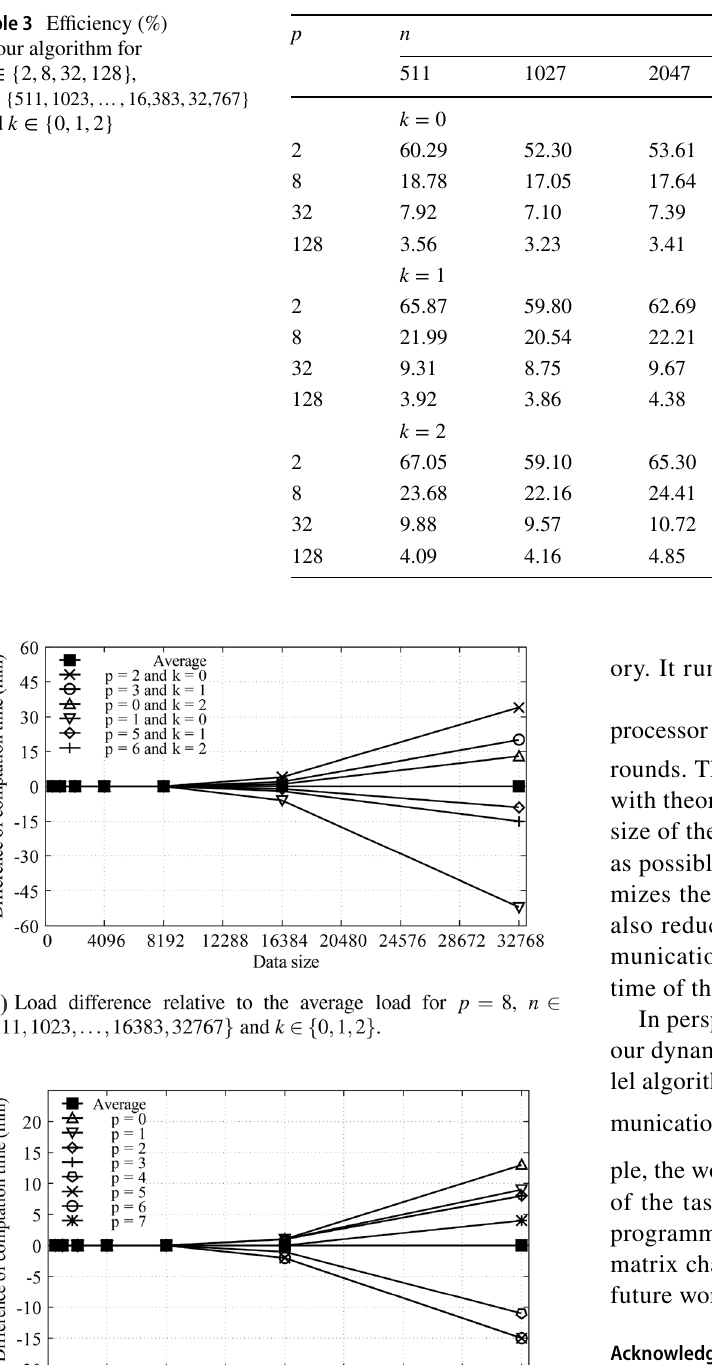
of our algorithm for p ∈ { 2,8,32,128 } , n ∈ { 511,1023, … ,16,383,32,767 } 0,1,2 } and k ∈ {